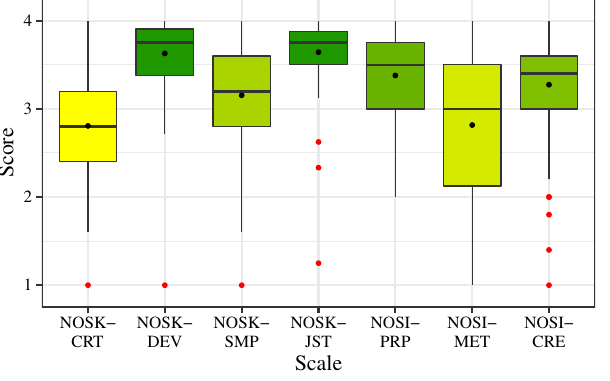
FIG. 2. Adequateness of students ’ beliefs by cohorts (A, B, C from left to right). Higher scores indicate more appropriate beliefs in the respective areas. Horizontal bars indicate scale medians, black dots indicate arithmetic means, red dots represent